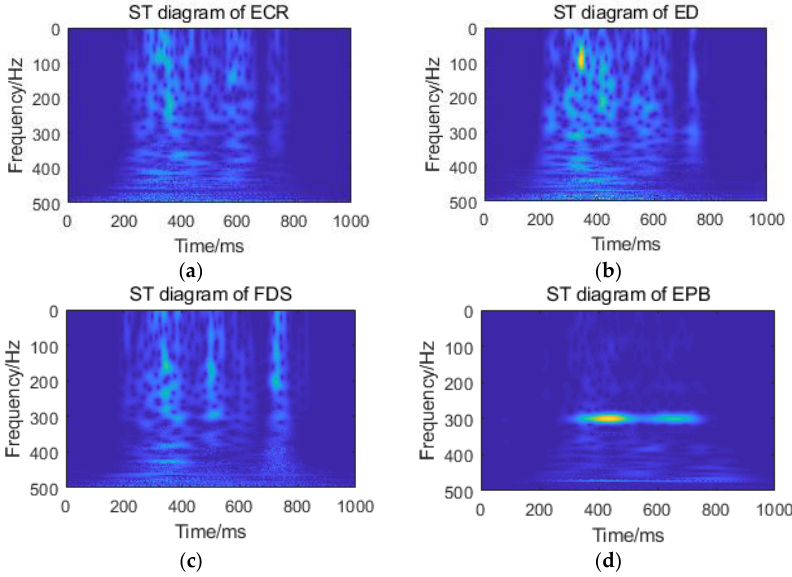
Figure 9. ST diagram of sEMG signals: ( a ) TFM diagram of ECR; ( b ) TFM diagram of ED; ( c ) TFM diagram of FDS; and ( d ) TFM diagram of EPB.